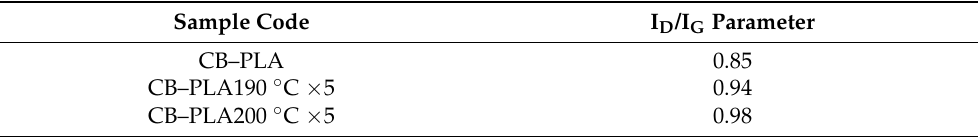
Table 4. Values of I D /I G ratio calculated from the Raman spectra for CB–PLA